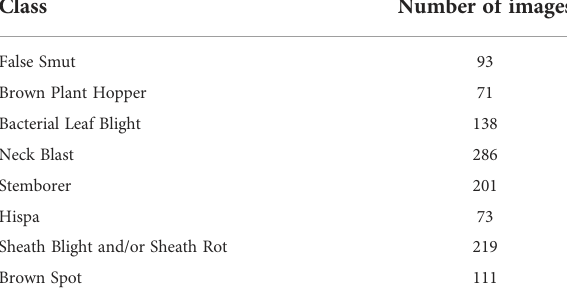
TABLE 10 Rice pest and diseases dataset